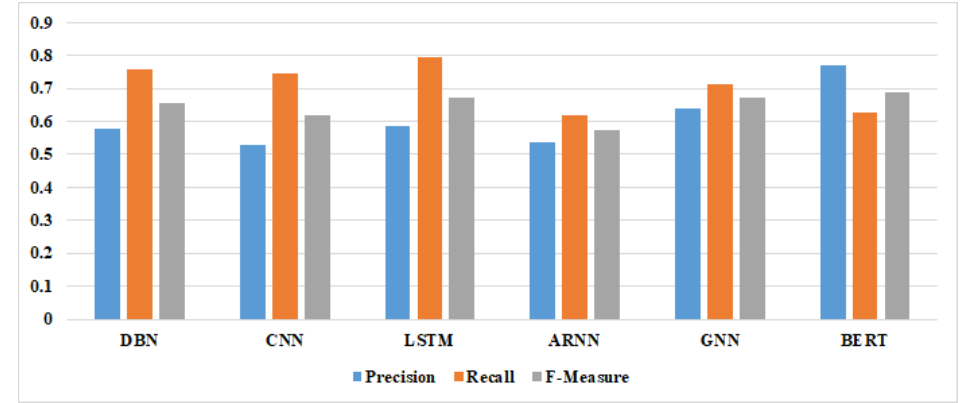
Figure 10. Average precision, recall, and f-measure of DL techniques used in the semantic features- based